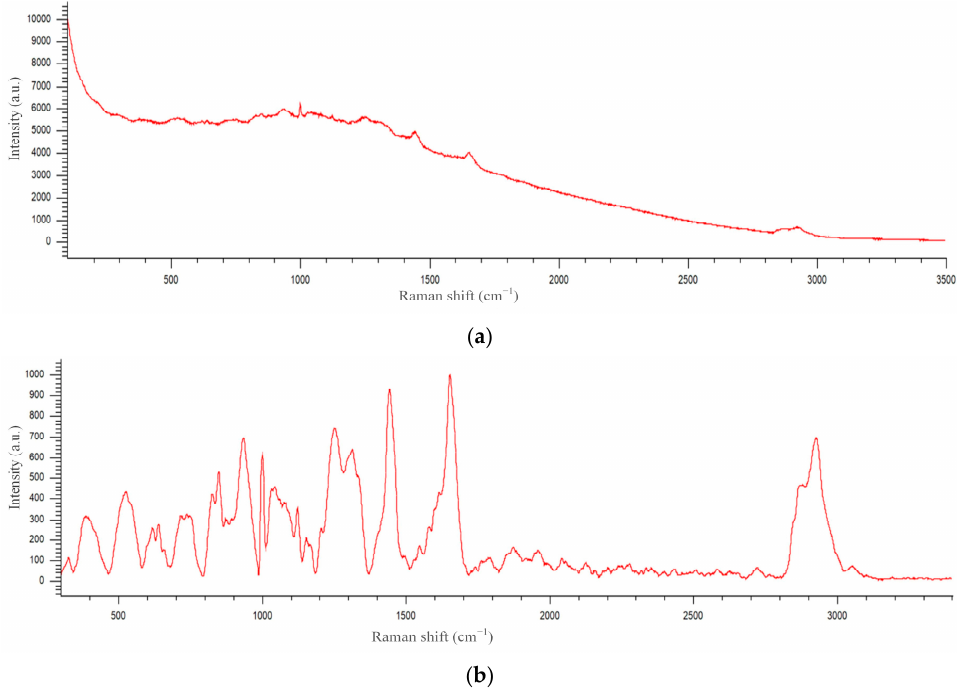
Figure 5. An example of a Raman spectrum before ( a ) and after ( b ) background subtraction.